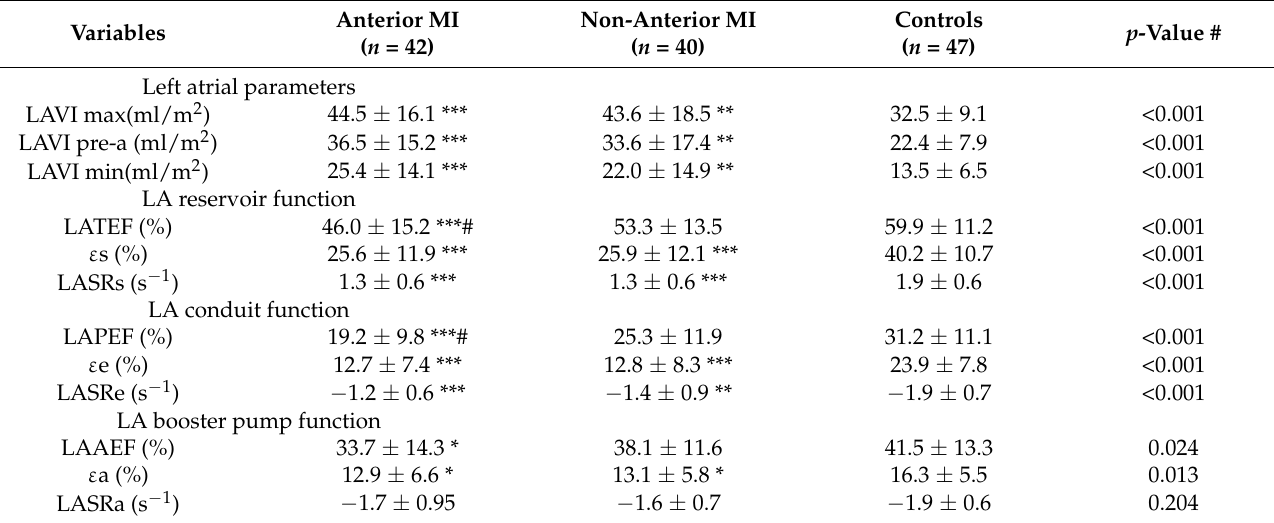
Table 3. LA volumetric and deformation parameters assessed by CMR-FT.